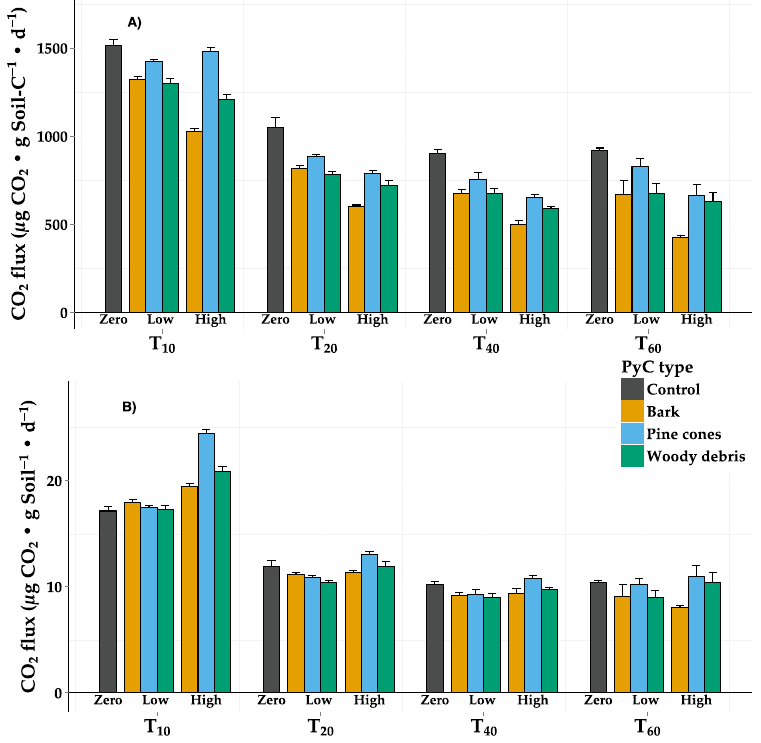
Figure 3. CO 2 flux, in terms of ( A ) g soil C per day and ( B ) g soil per day, of soils incubated with charred bark (yellow), charred pine cones (blue), or charred woody debris (green) at zero (black, control), low (0.1%), or high (1.0%) PyC concentrations. The CO 2 concentrations were measured on days 10, 20, 40, and 60 (T 10, T 20 , T 40 , T 60 , respectively). The error bars represent one standard error. Results from means separation tests are reported in Table